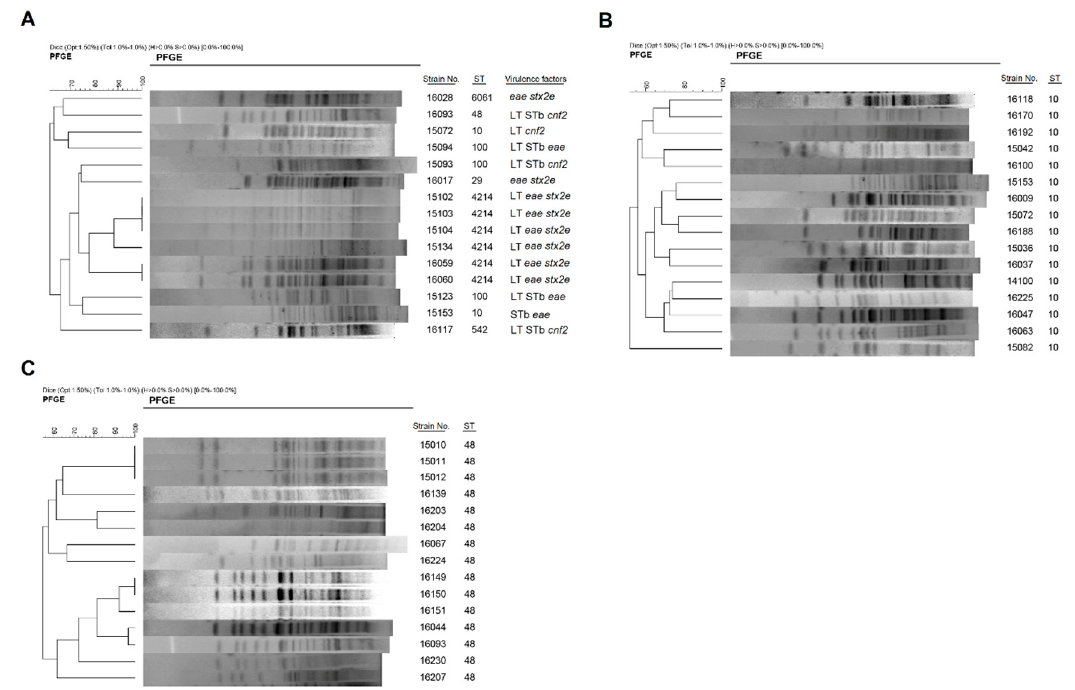
Figure 3. Pulsed-field gel electrophoresis (PFGE) of Xba I-digested DNA from E. coli hybrids. PFGE patterns, sequence types (STs) and virulence factors (VFs) of ( A ) hybrid E. coli strains, and ( B , C ) PFGE patterns of E. coli isolates with the same STs are shown.